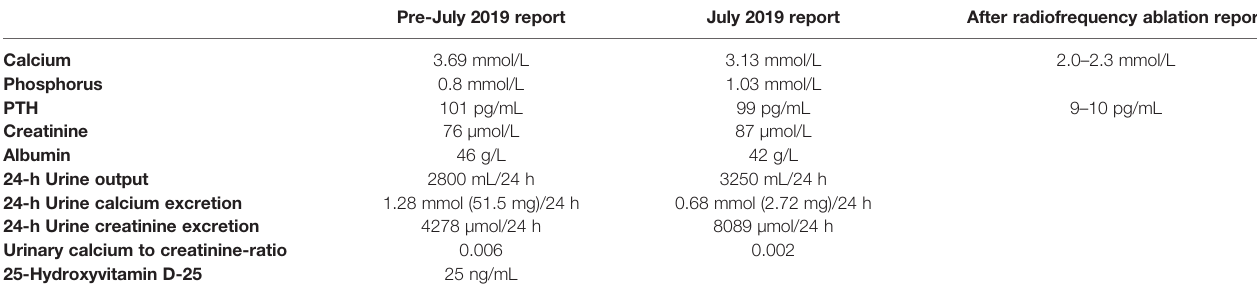
TABLE 1 | Key patient clinical data.